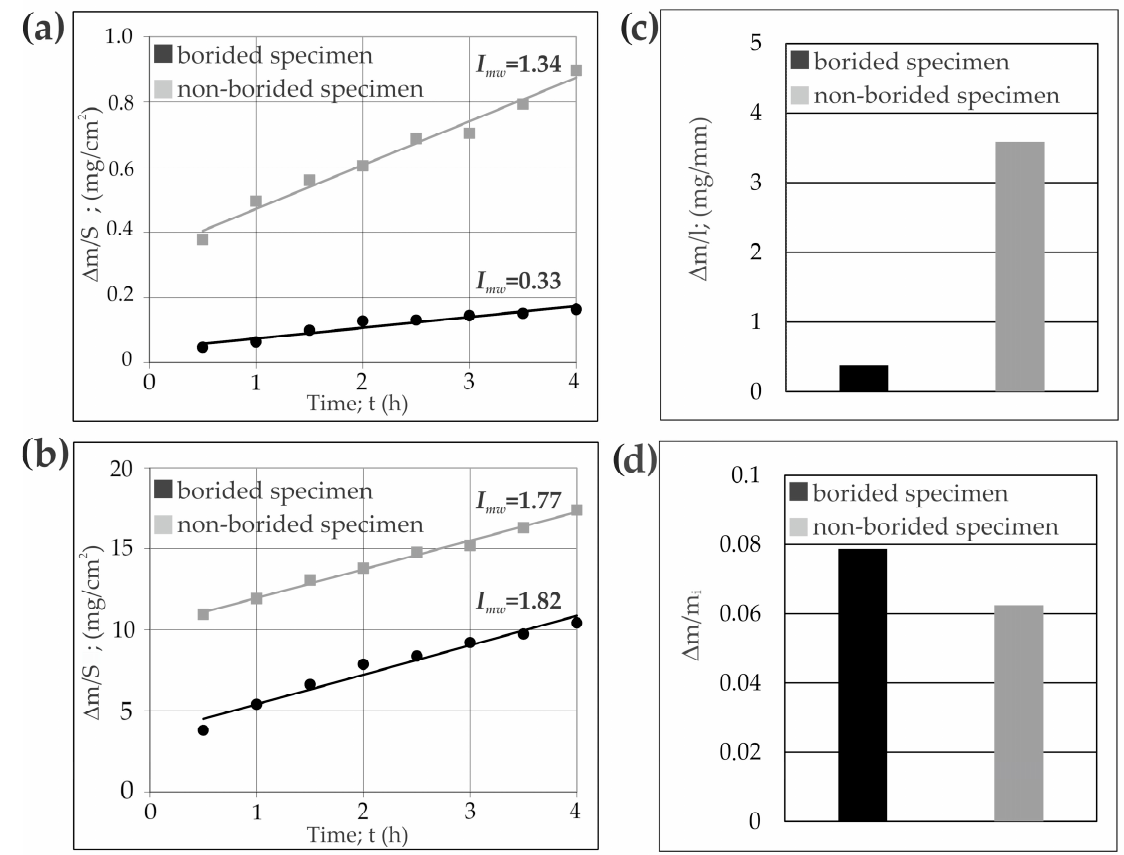
Figure 17. Results of wear resistance tests: ( a ) mass loss of specimens on a unit of friction surface vs. time of friction with calculated I mw factors, ( b ) mass loss of counter-specimens on a unit of friction surface vs. time of friction with calculated I mw factors, ( c ) ratio of mass loss of specimens to length of wear path, (d) relative mass loss of counter-specimens.